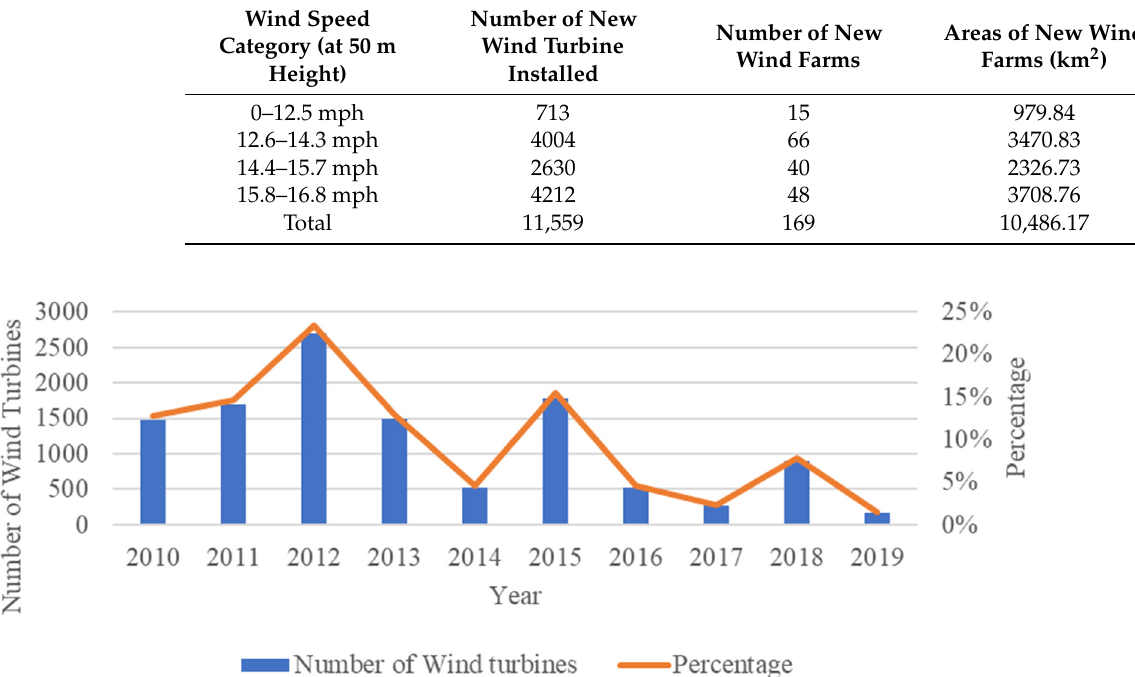
Figure 7. Number of wind turbines installed each year in Texas between 2010 and 2019.